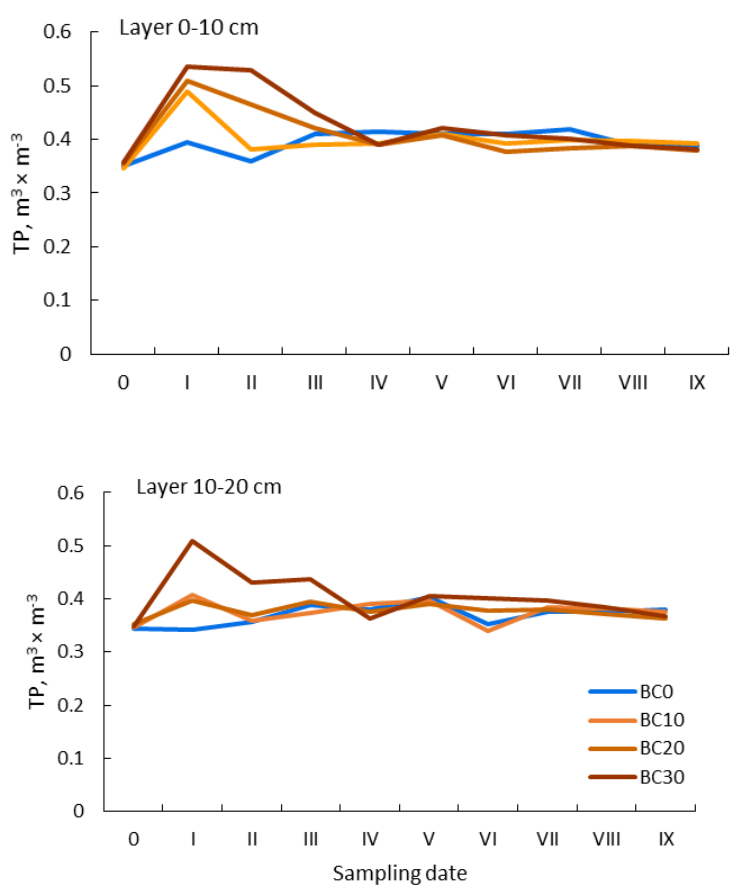
Figure 3. Total porosity (TP). Explanations as for Figure 1.